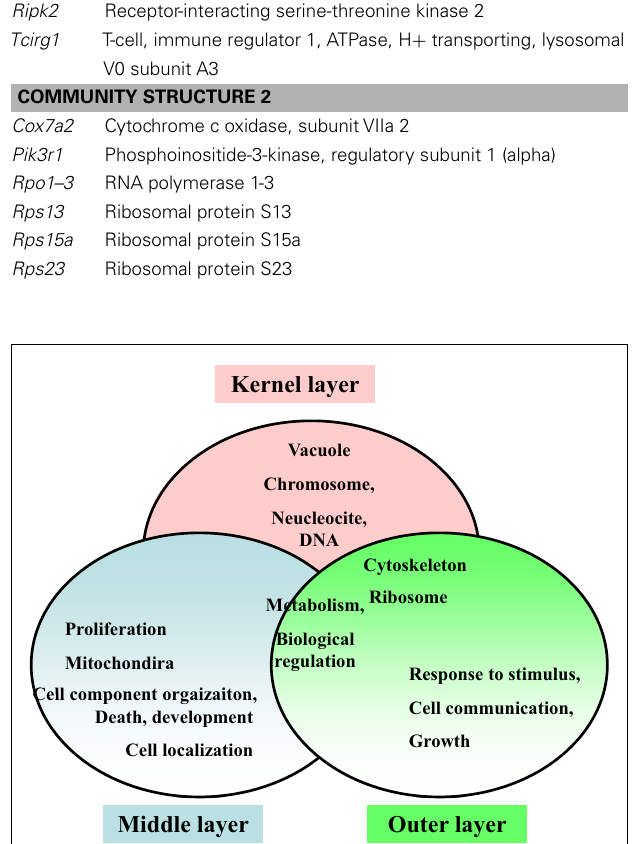
FIGURE 9 | Enriched functional annotations in three layers of the hypoxia-associated genetic core